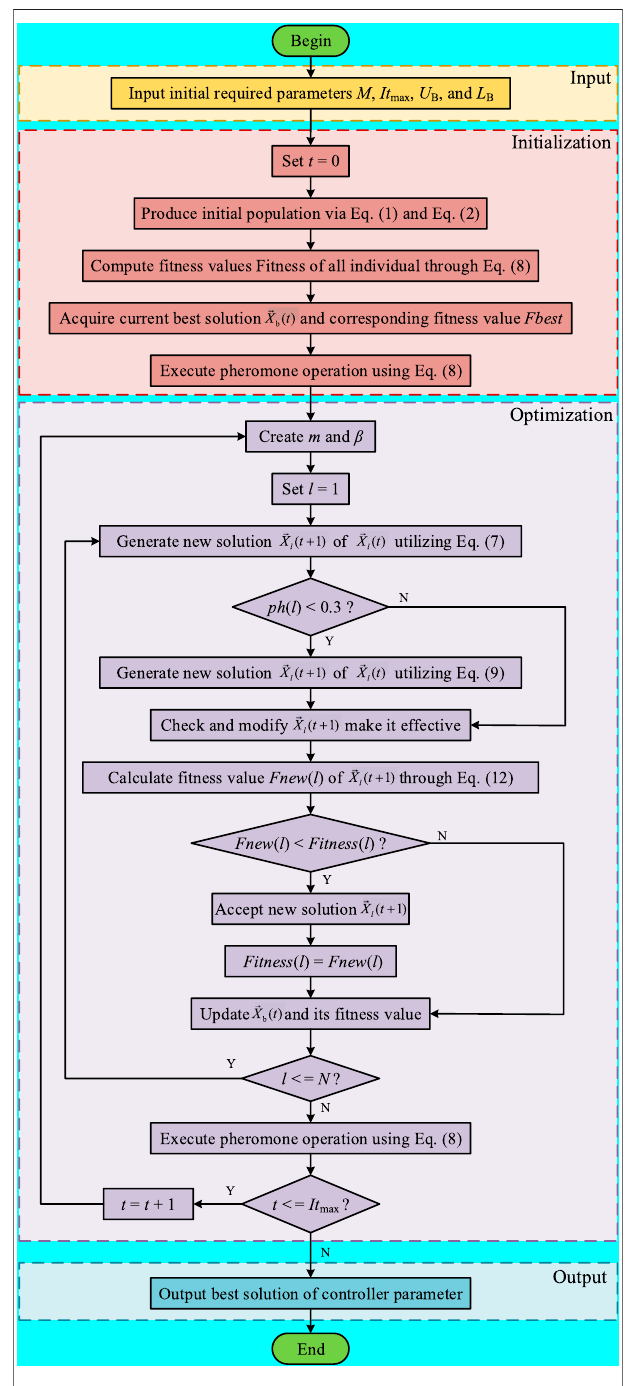
FIGURE 5 | Parameter optimization fl ow chart of controller based on